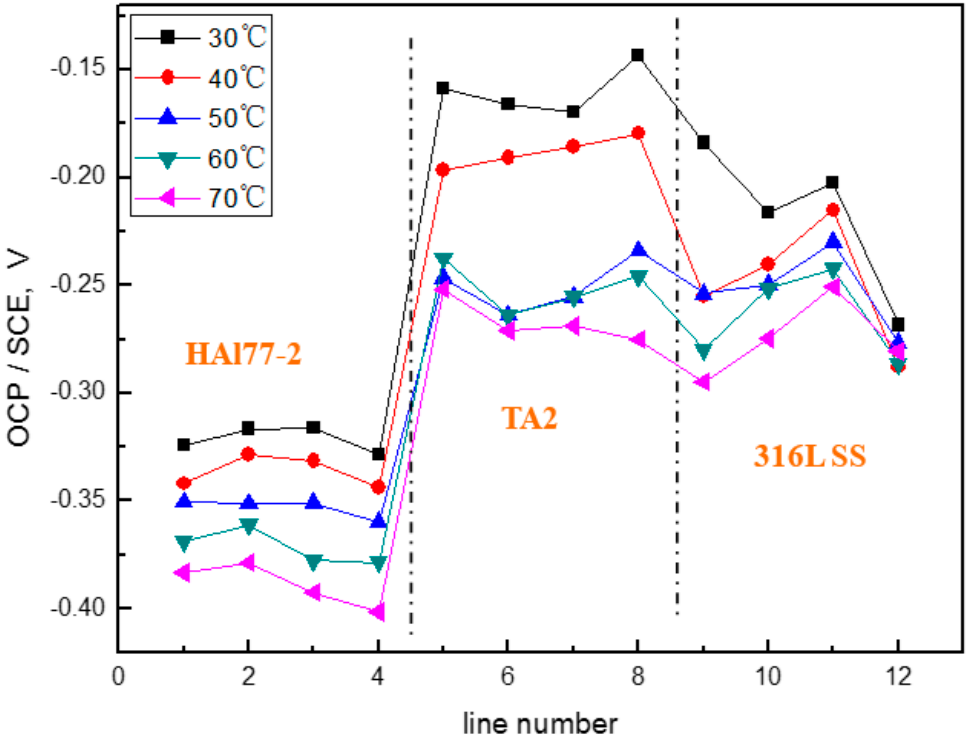
Figure 8. Average OCP distribution of each microelectrode line for WBE2 after immersion in artificial seawater at different temperatures.